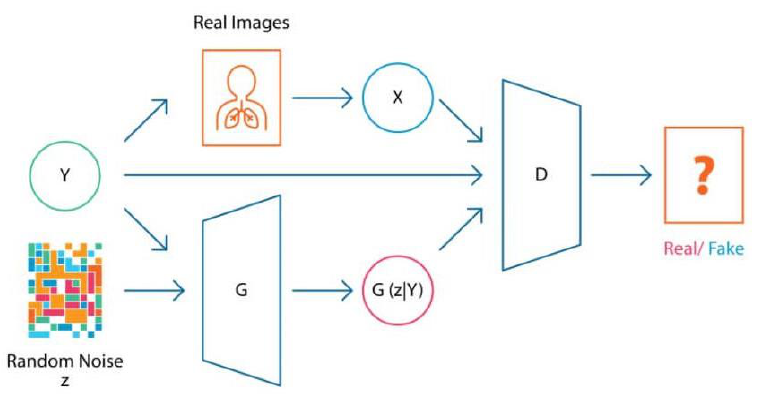
Figure 2. An overview of the CGAN architecture.